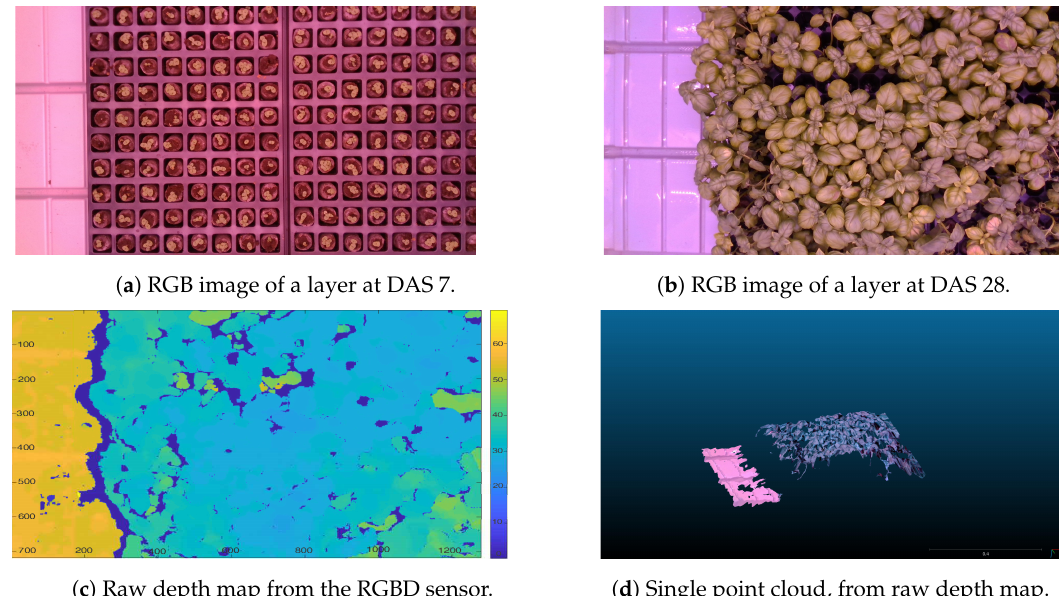
Figure 3. The data collected include 1728 color images and 1728 depth maps of the plants (better seen in